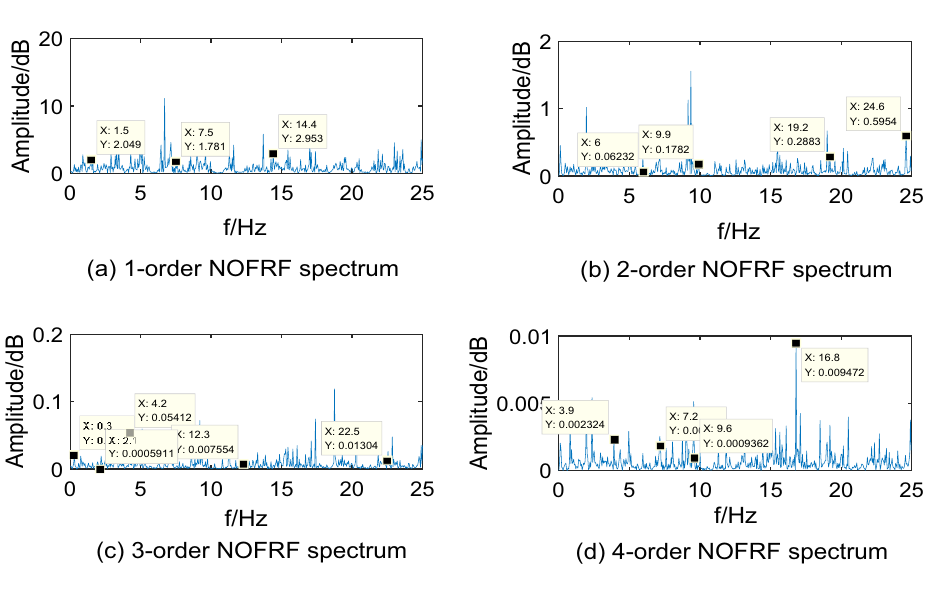
Figure 15. NOFRF spectrum of first 4-order in